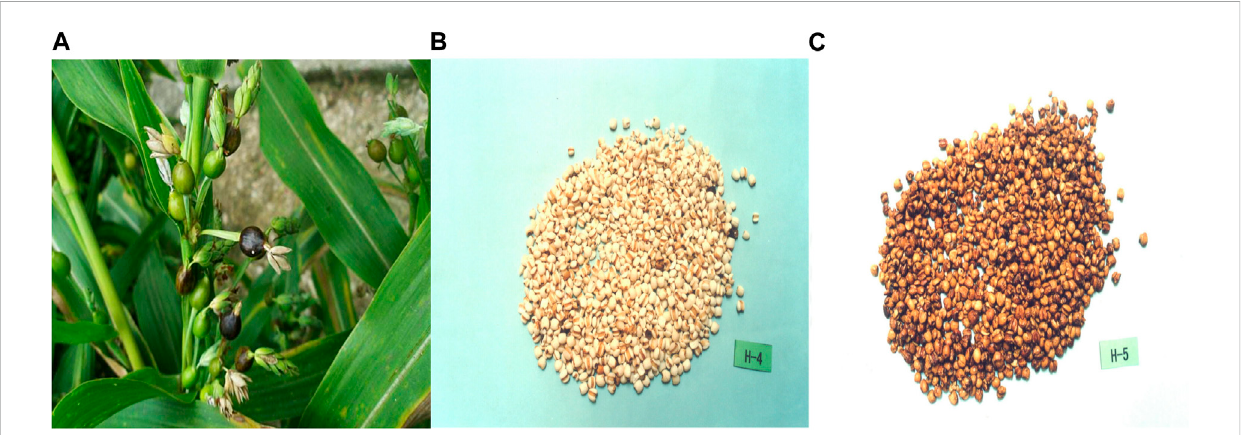
FIGURE 1 Representative images of Coicis Semen. (A) , Raw Coicis Semen. (B) , Fried Coicis Semen. (C) , Seed kernels of Coicis Semen, which are broadly ovate or oblong in shape, 4 – 8 mm in length, and 3 – 6 mm in width. Pictures are from the Shanghai Institute of Organic Chemistry of the Chemical Abstracts Service Online Database [CAS(DB/OL)], accessible at: